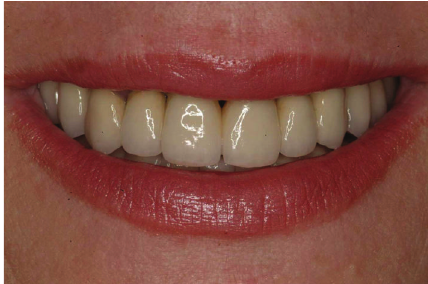
Figure 40: From an esthetic standpoint, the objective of restoring a pleasant and harmonious smile line was achieved.